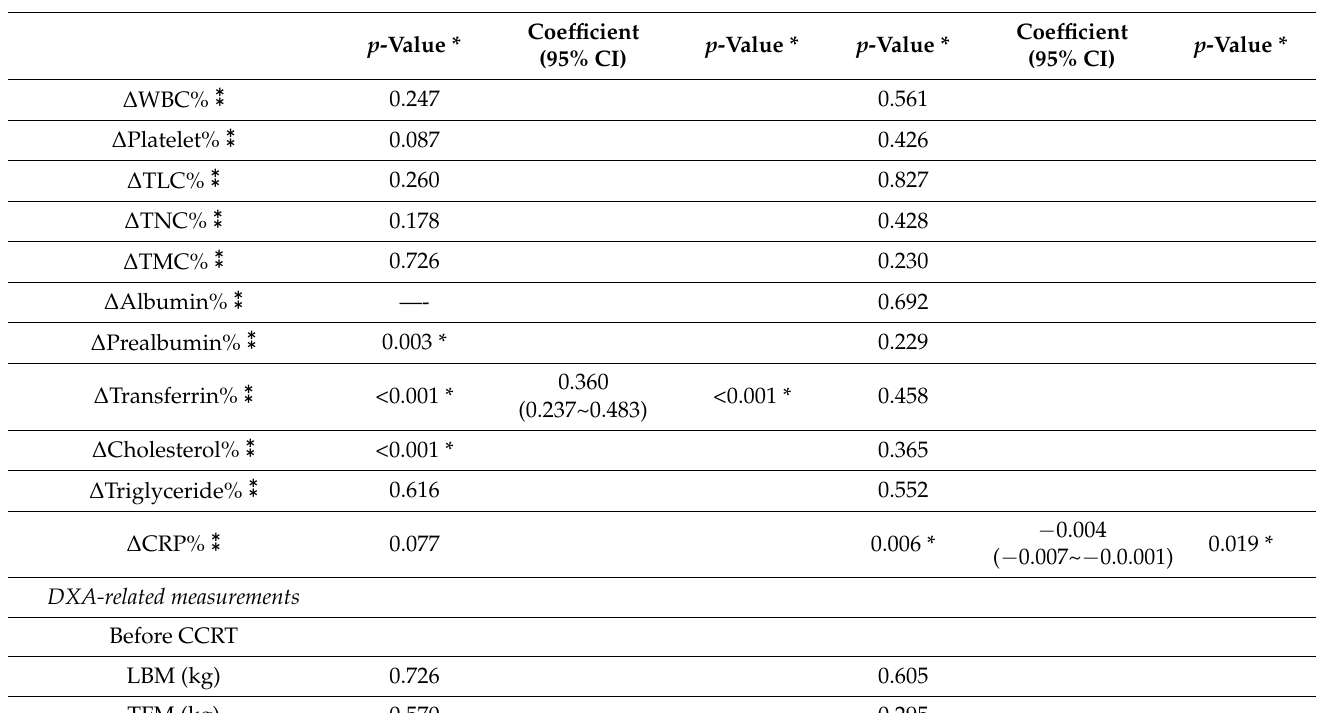
Table 1. Clinicopathological variables, biochemical and nutrition–inflammation data, anthropomet- ric and body composition characteristics, serum HLOP metabolites, and treatment-related factors of 44 patients with LAHNSCC completing the CCRT course, stratified by treatment interruption.